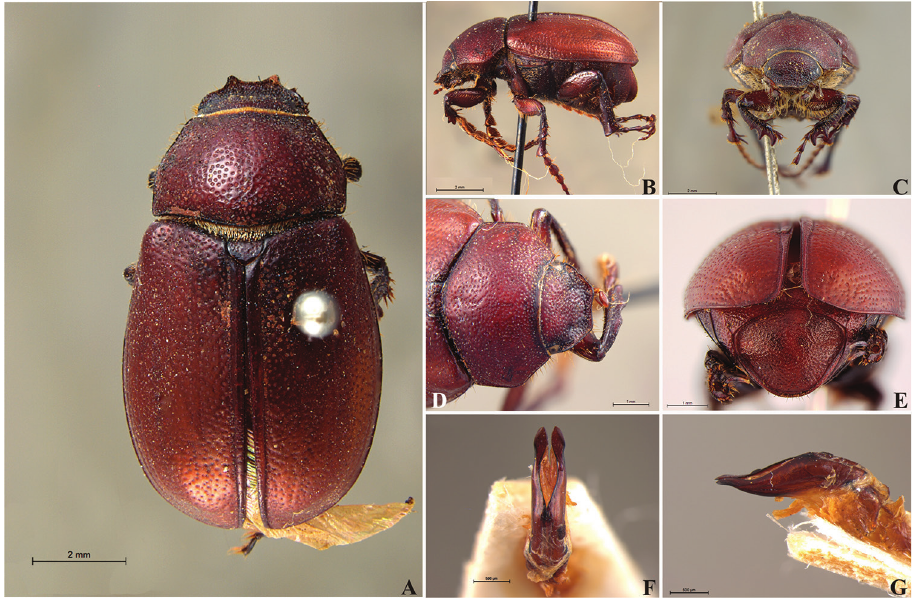
Figure 60. Liogenys concolor Blanchard. A Dorsal view B Lateral view C Frontal view D Clypeus and pronotum E Pygidium F Parameres, dorsal view G Parameres, lateral